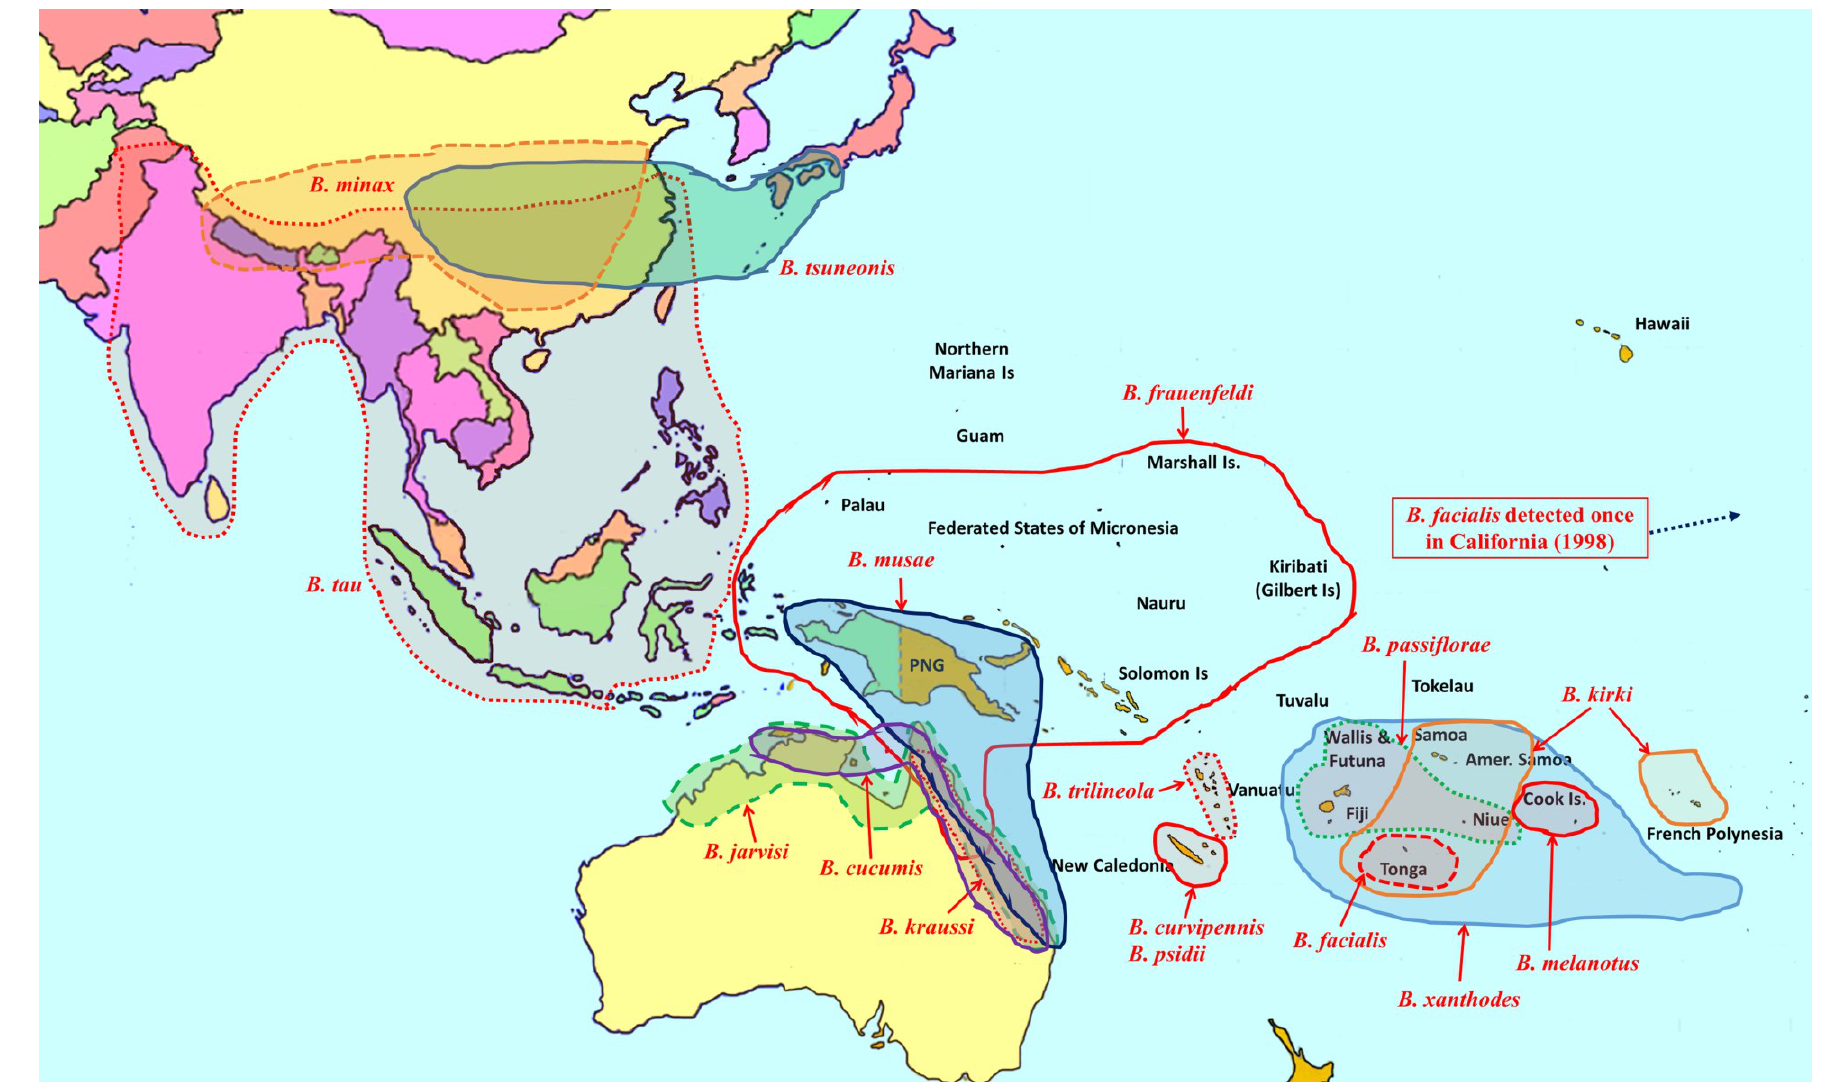
Figure 4. Distribution of Category B pest species in the genus Bactrocera